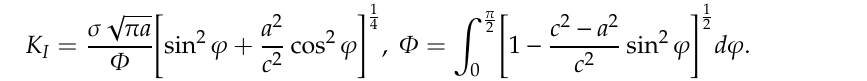
Figure 12. Geometric dimensions of embedded elliptical cracks.